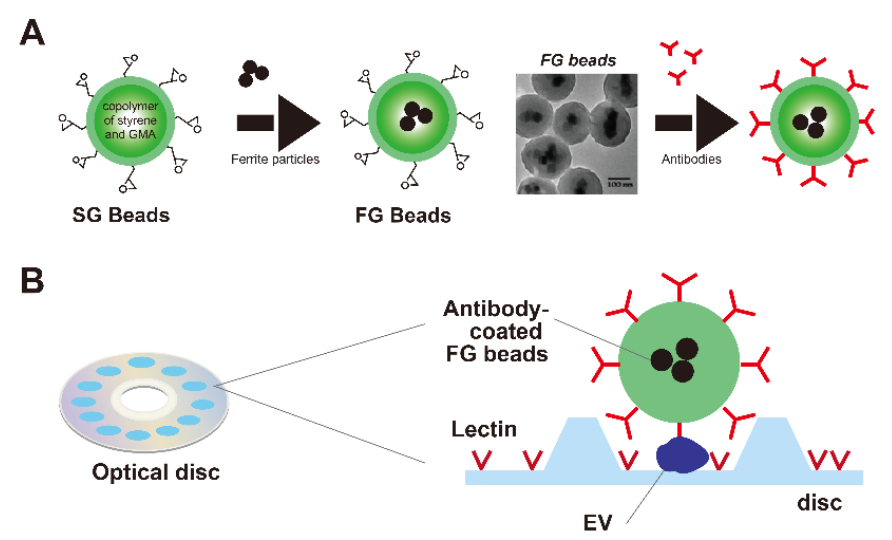
Figure 2. ( A ): Construction of SG and ferrite and glycidyl methacrylate (FG) beads. SG beads are composed of styrene and glycidyl methacrylate (GMA) (left). FG beads are prepared with surface- modified ferrite particles, styrene, and GMA (middle). Transmission electron microscopy image is shown (middle). Antibodies can be immobilized on the surface of FG beads (right). Modified from Inomata et al. and Nishino et al. ( B ): Schematic image of the quantification of extracellular vesicles (EVs). Candidate lectins were coated on the optical disc of the ExoCounter system. Lectin-binding EVs in the sera of pancreatic cancer patient or cell lines were captured on the disc and labeled with anti-CD9 Ab-conjugated nanoparticles. The absolute numbers of labeled EVs were quantified using the optical disc drive of the ExoCounter. Modified from Yokose et al.